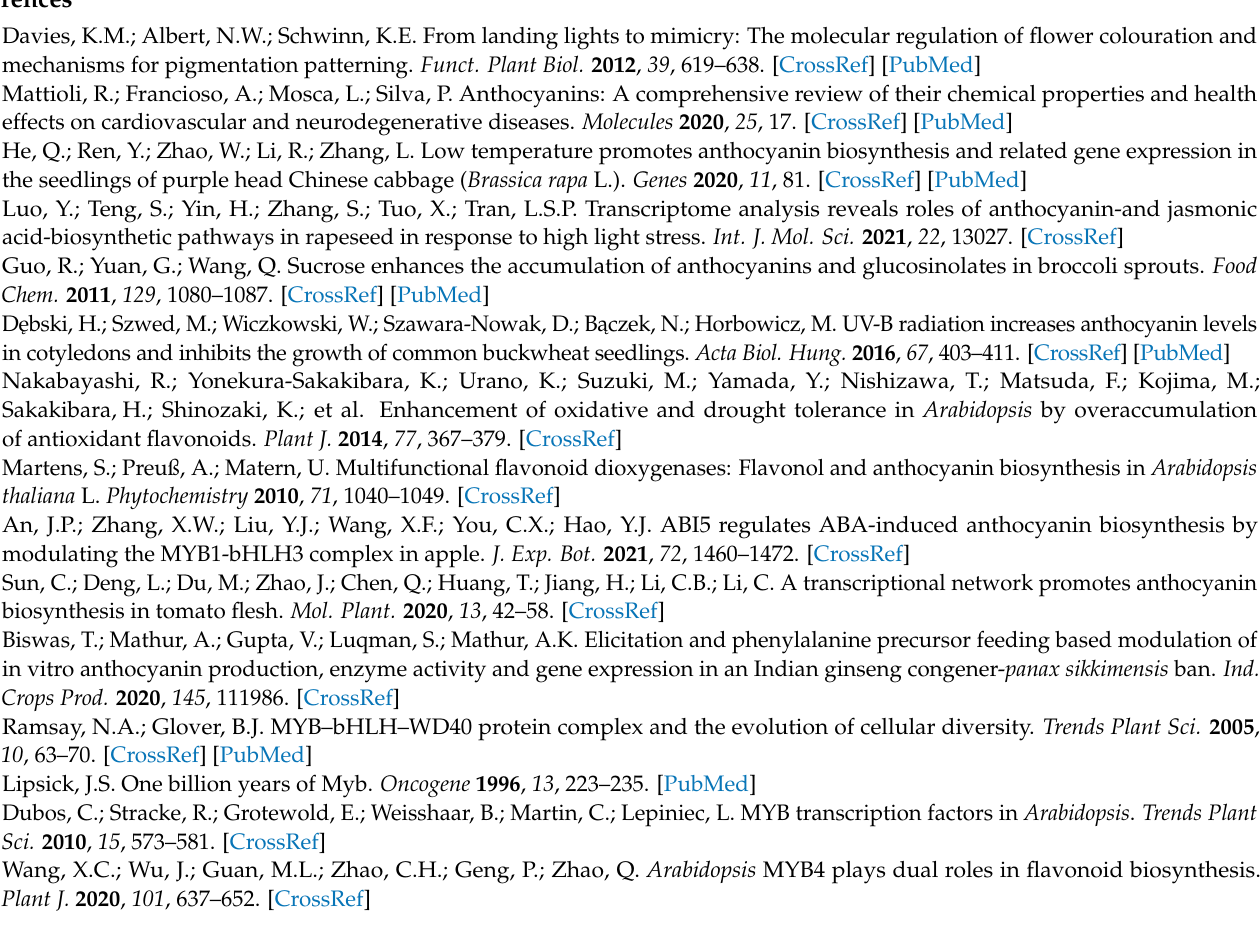
Table S4: Classification of GO terms; Table S5: GO classification of biological process; Table S6: GO classification of cell component; Table S7: GO classification of molecular function; Table S8: Result of GO enrichment annotation: Table S9: Result of KEGG pathway